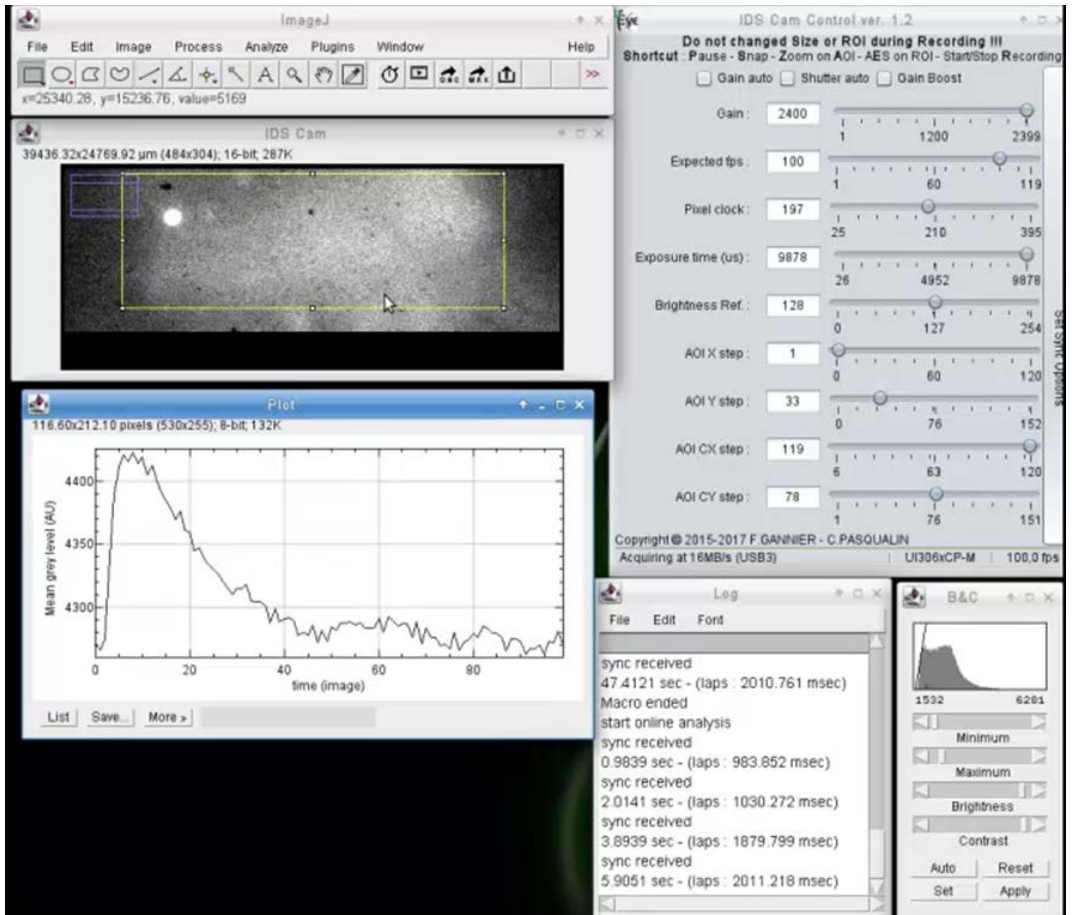
Figure 2 . Example of online video analysis of fast calcium oscillations in a cardiac myocyte electrically stimulated. This type of analysis enables, for example, real-time measurement of the calcium transient features (e.g., amplitude, duration, rise, and decay time), so the effects of drugs can be directly observed and recorded without having to wait for the end of the experiment. It also avoids having to record the video signal for the entire duration of the